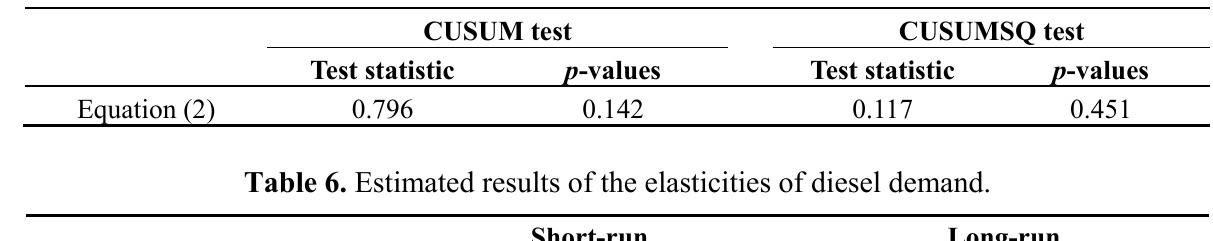
Table 5. Results of CUSUM and CUSUMSQ tests.